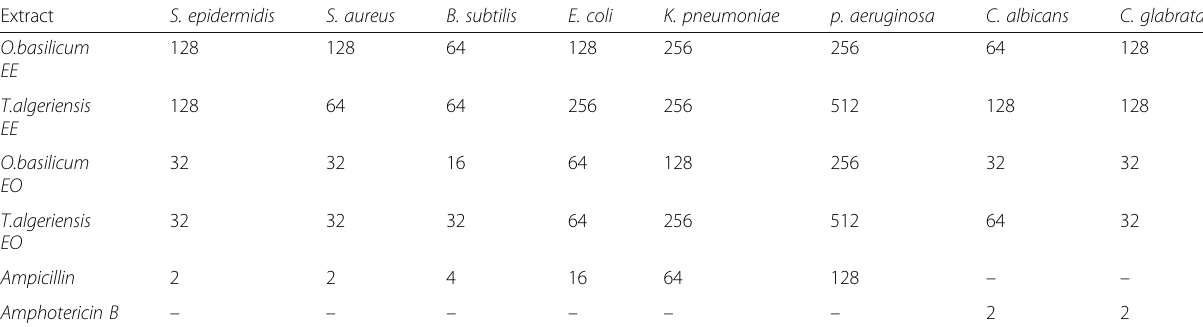
Table 5 Antimicrobial activities of O. basilicum and T. algeriensis ethanolic extracts and essential oils against eight pathogenic microorganisms expressed as MIC ( μ g/mL) values Extract